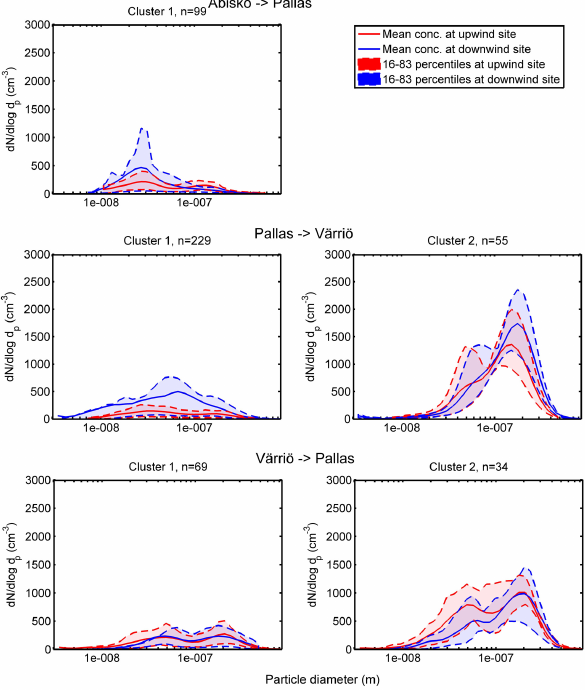
Fig. 10. The dynamics of the number particle size distributions when air masses were moving from one measurement site to an- other. Similar to Fig. 9, but covering the winter season,